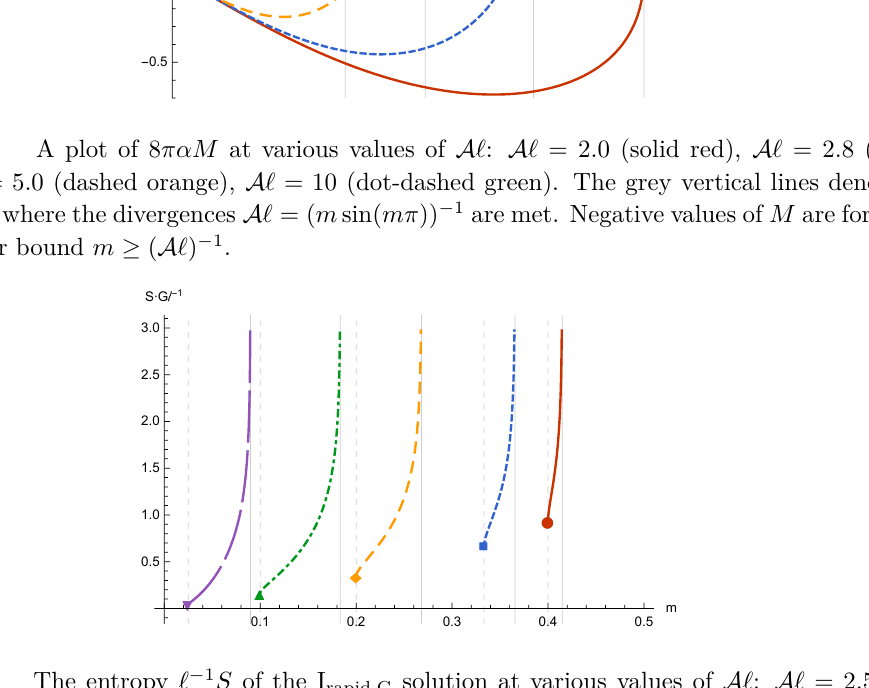
Figure 24 . The entropy ‘ − 1 S of the I rapid,C solution at various values of A ‘ : A ‘ = 2 . 5 (solid red), A ‘ = 3 . 0 (dotted blue), A ‘ = 5 . 0 (dashed orange), A ‘ = 10 (dot-dashed green), A ‘ = 40 (long-dashed purple). A solid grey vertical line denotes an asymptote where the divergence A ‘ = ( m sin( mπ )) − 1 is met. A dashed grey line dentotes the value of m for a massless solution; the entropy at this point is marked with a